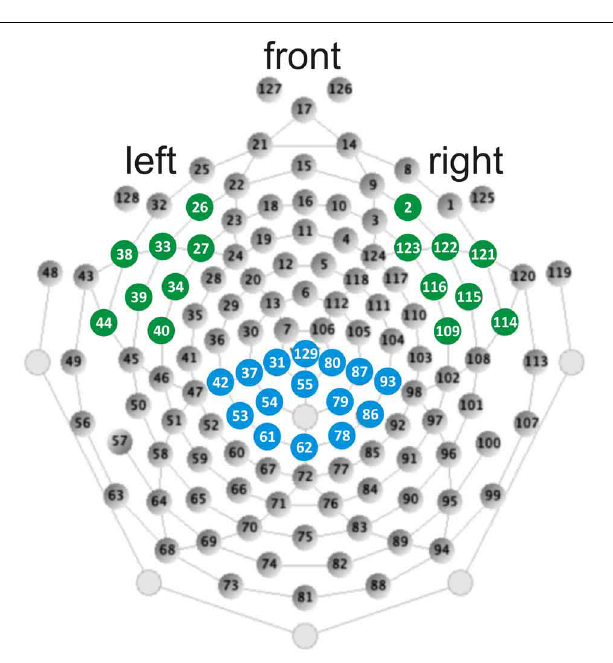
FIGURE 2 | Illustration of the 128-channel-system and electrode position taken from Electrical Geodesics Inc. (2007). Filled blue circles depict electrodes included in the ROI of the N400. Filled green circles depict electrodes included in the LH and RH ROIs of the N300.